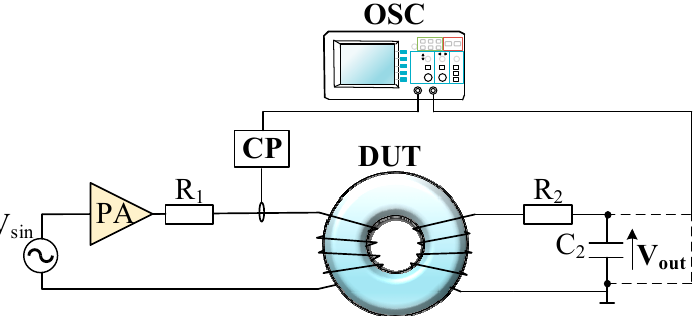
Figure 7. Setup to measure the hysteresis loop.